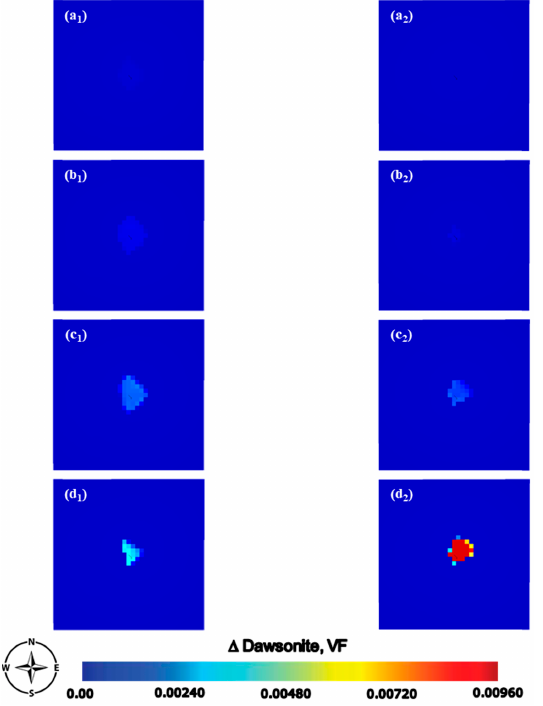
Figure A3. Plan view diagrams illustrating the simulated dawsonite volume fraction evolution for the base case from the arkosic layer top view ( a 1 , b 1 , c 1 , d 1 ) and homogenous case from the Upper Mt. Simon top view ( a 2 , b 2 , c 2 , d 2 ) at ( a ) 30 years, ( b ) 100 years, ( c ) 1000 years, and ( d ) 10,000 years. Each figure’s size is 35 km × 35 km (x, y). Energies 2022 , 15 , x FOR PEER REVIEW